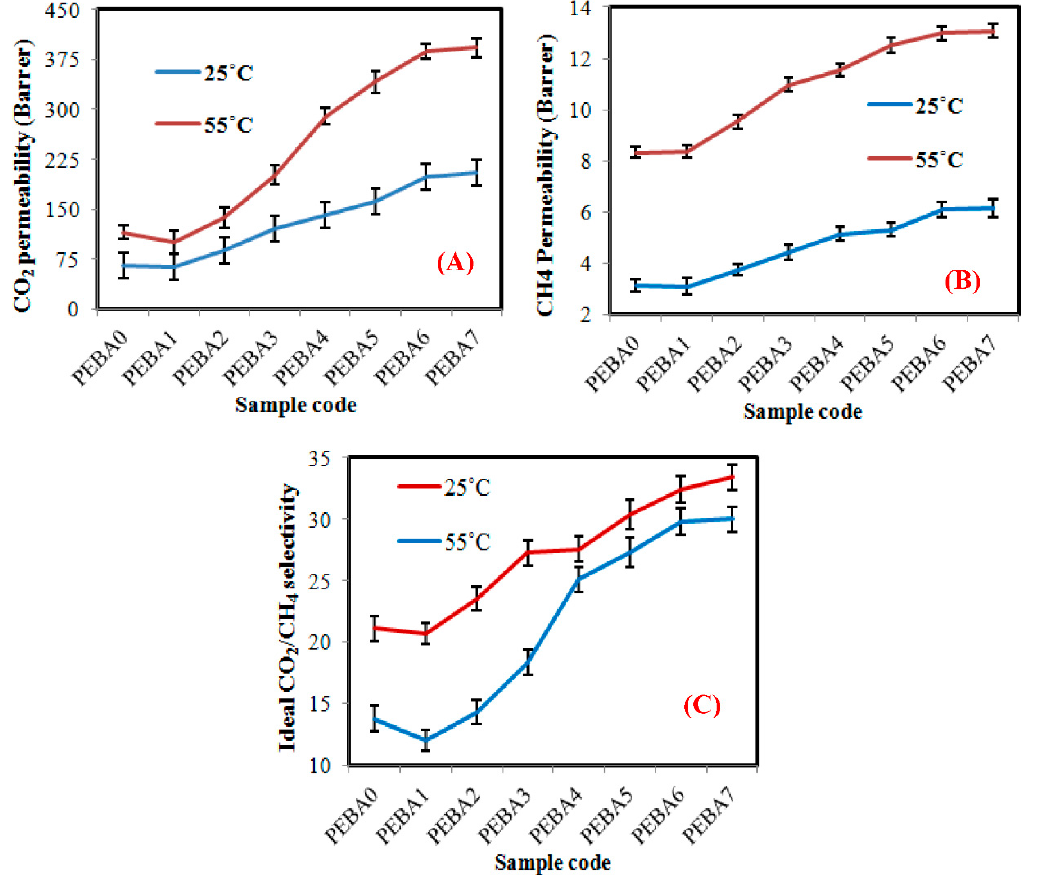
Figure 10. ( A , B ) CO 2 and CH 4 permeability and ( C ) Ideal CO 2 /CH 4 selectivity of the synthesized membranes at 2 bar and various temperatures (25 and 55 °C). membranes at 2 bar and various temperatures (25 and 55